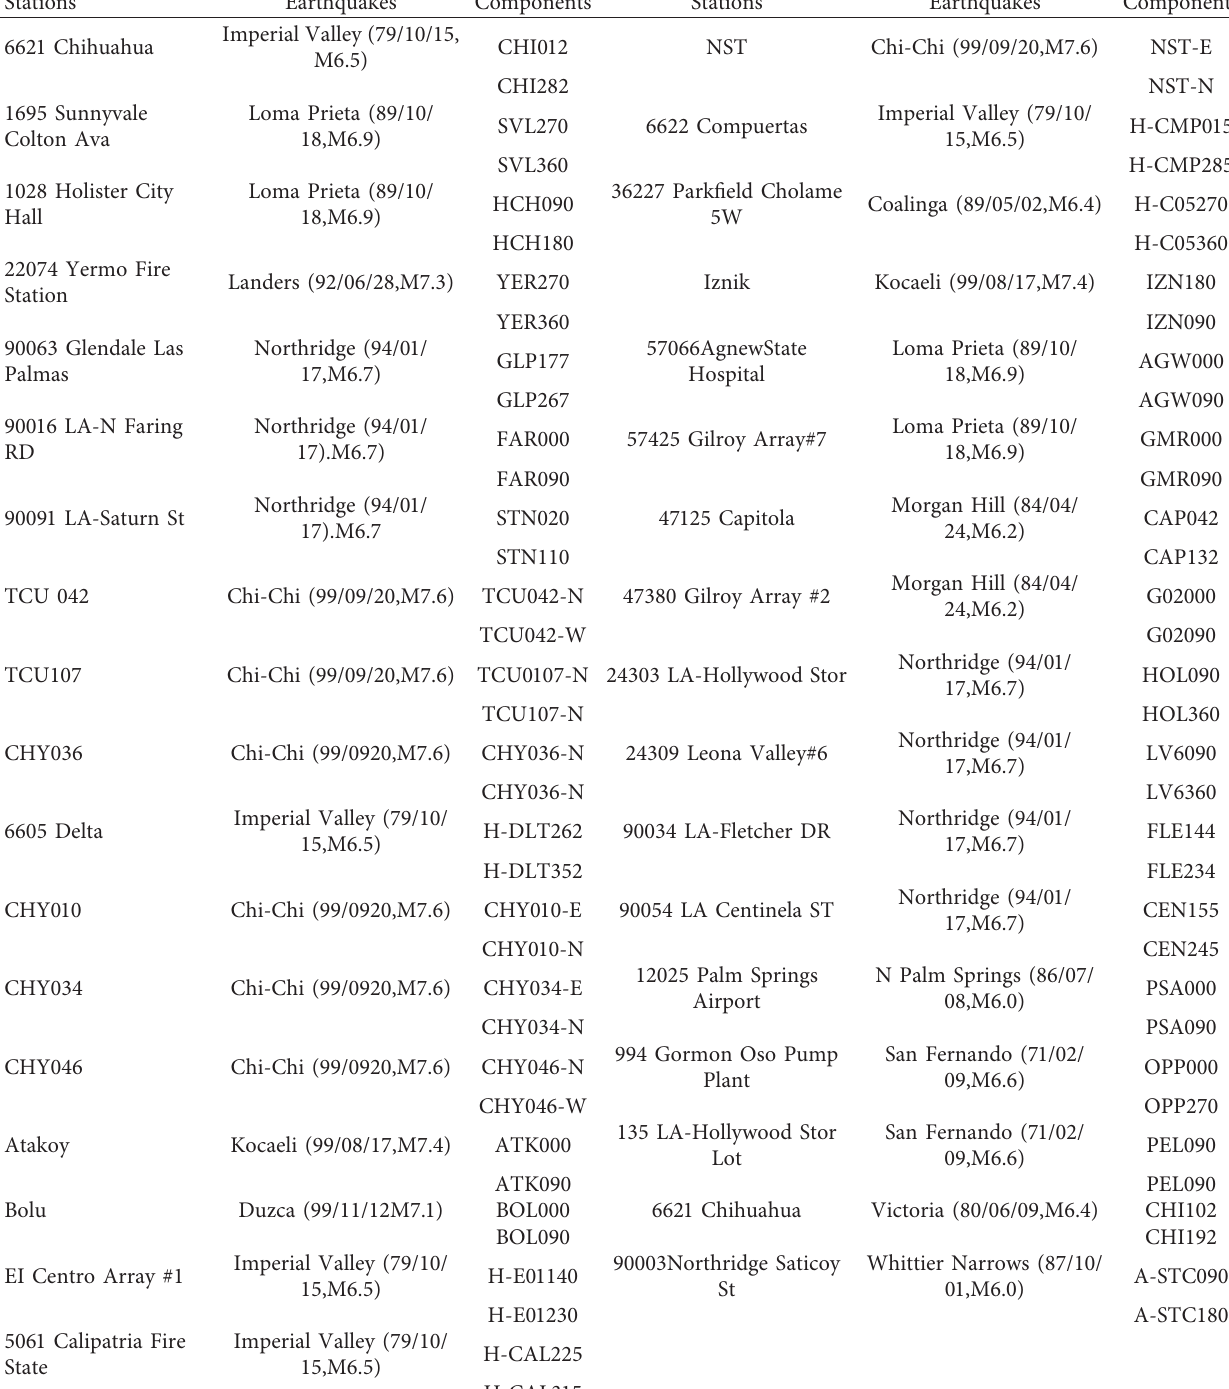
Table 2: The ground “A” records for ISS (35